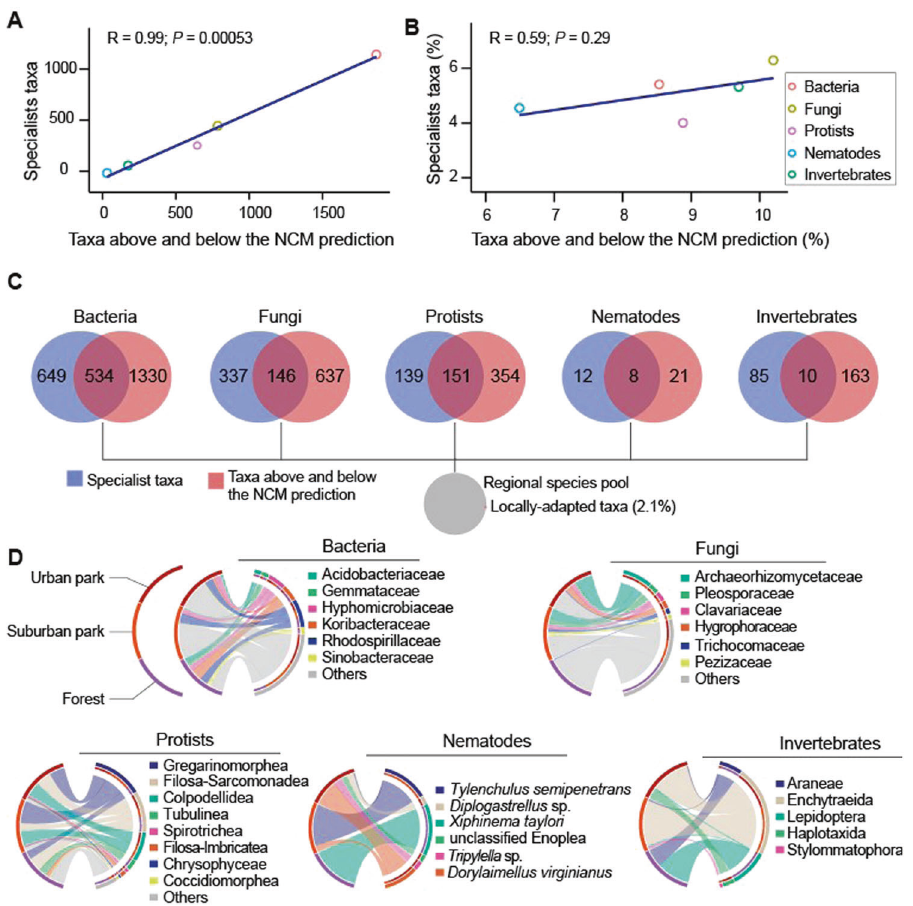
Fig. 6 Locally-adapted taxa resulting from the intersection between specialist taxa and taxa above and below the neutral model prediction. The linear regression between the absolute number of specialists and taxa above and below the neutral community model ( A ), the percentage ( B ), intersection of the neutral community model observations and niche breadth ( C ) and taxonomic composition of the identi fi ed locally-adapted taxa ( D